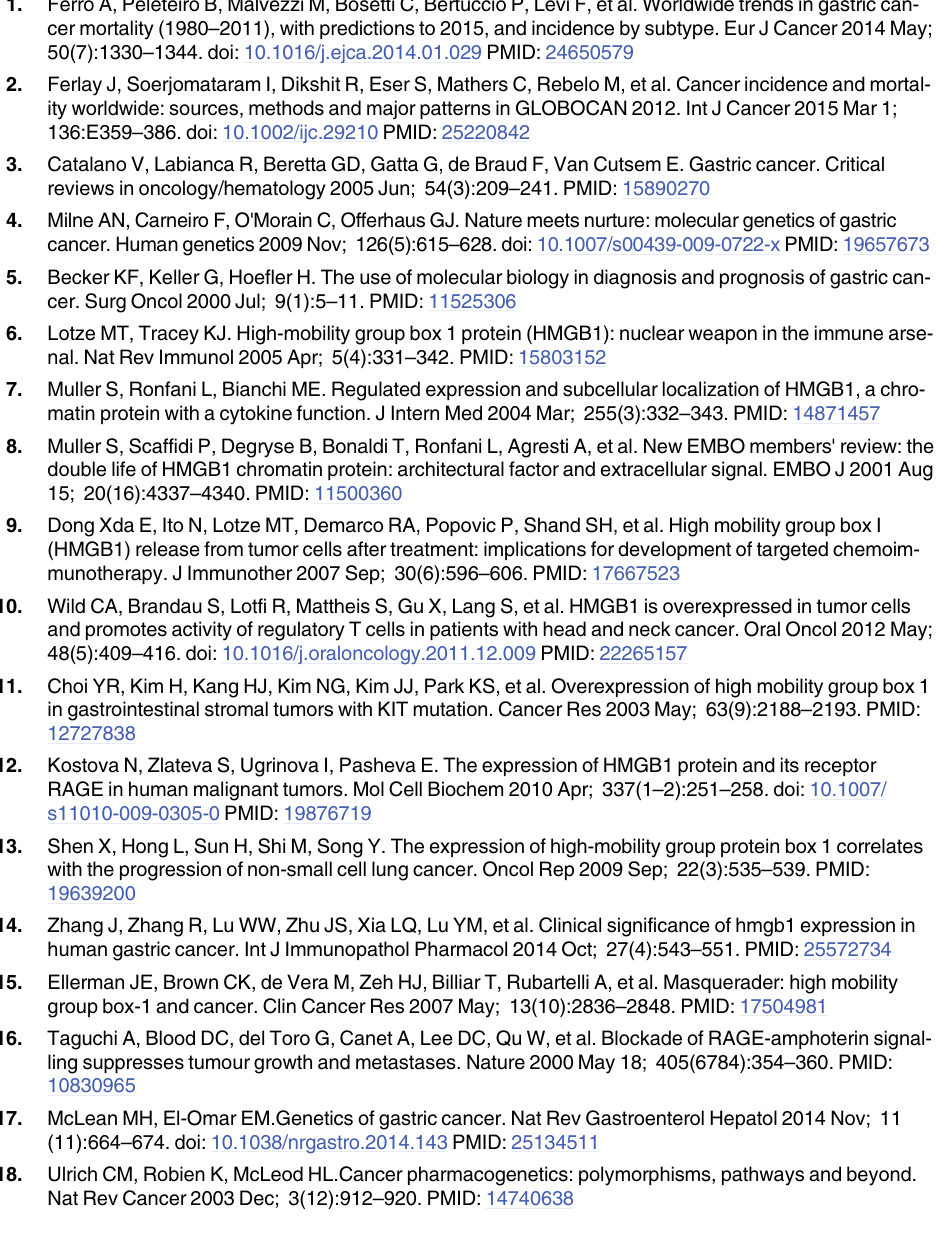
S3 Table. Distribution of patients' characteristics and prognosis analysis in the Training set and the Validation